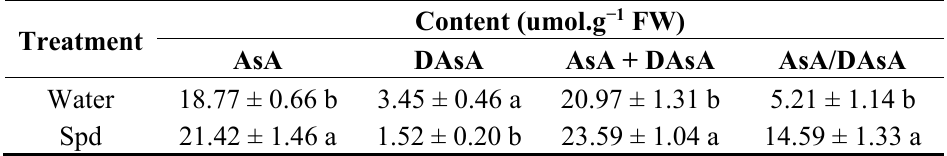
Table 4. The effect of seed priming with water or spermidine (Spd) on ascorbic acid (AsA) and dehydroascorbic acid (DAsA) content in seeds of white clover after 7 days of germination under 15% PEG. Values are mean ± SE ( n = 6). Different letters in a vertical column indicate significant difference between two treatments. LSD ( p ≤ 0.05).